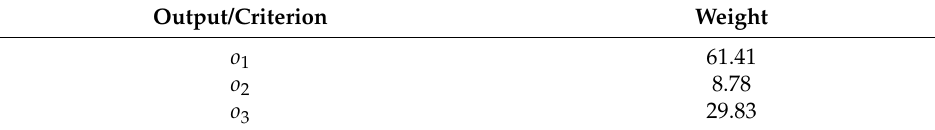
Table 10. Output weights for z =